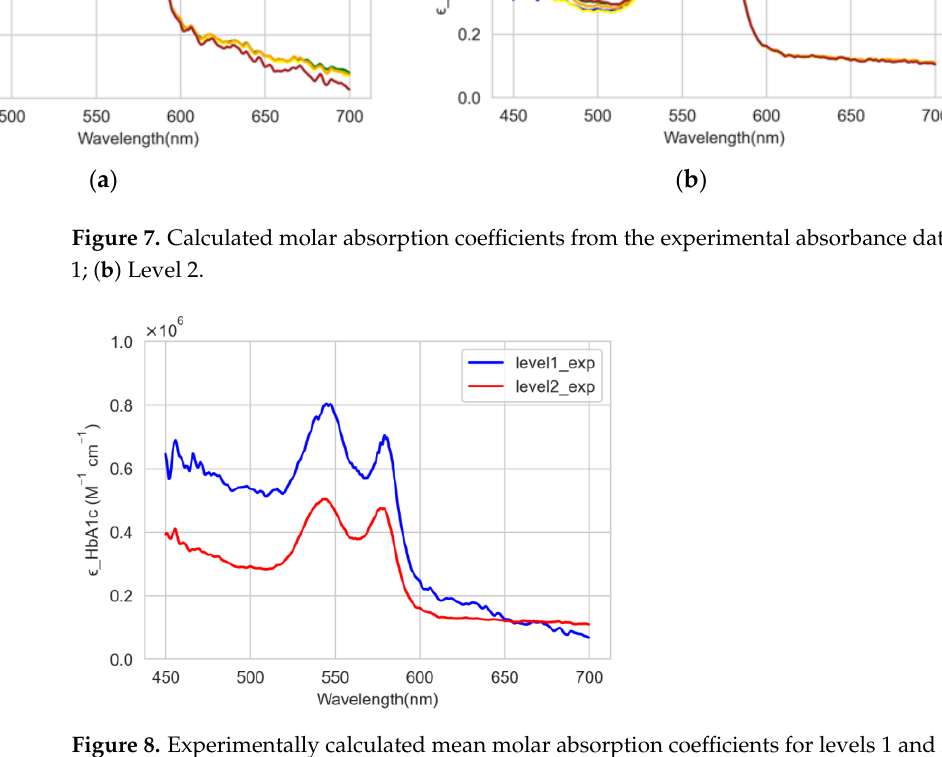
Figure 7. Calculated molar absorption coefficients from the experimental absorbance data. ( a ) Level 1; ( b ) Level 2.